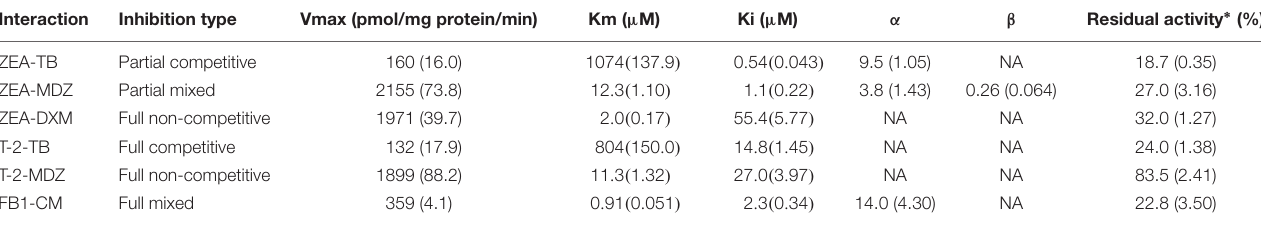
TABLE 2 | Results of the curve fitting